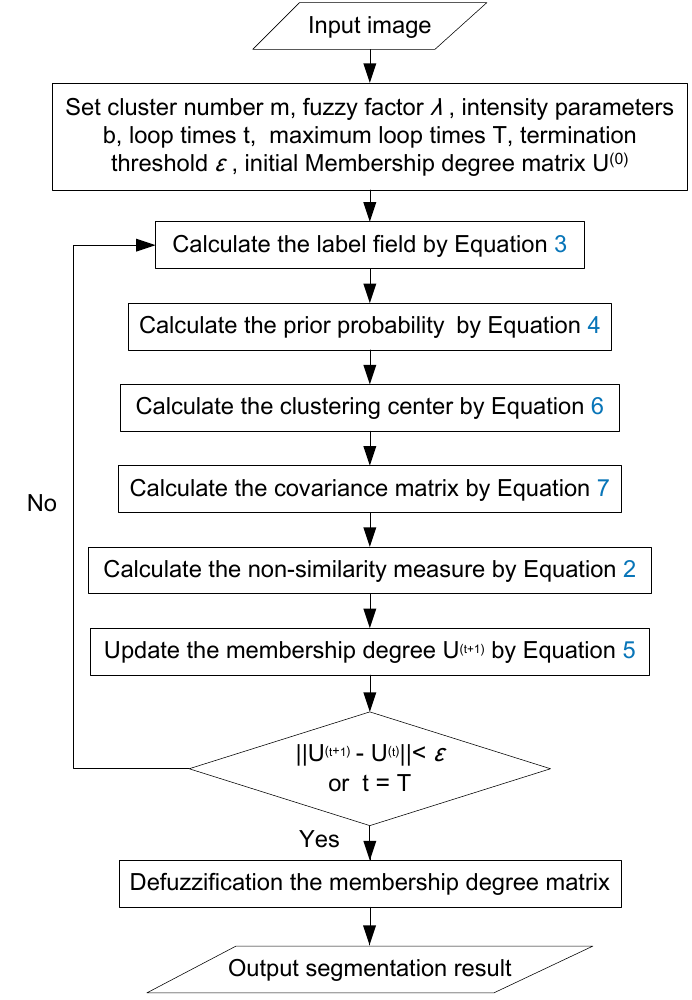
Figure 1. Graphical flowchart of the image segmentation